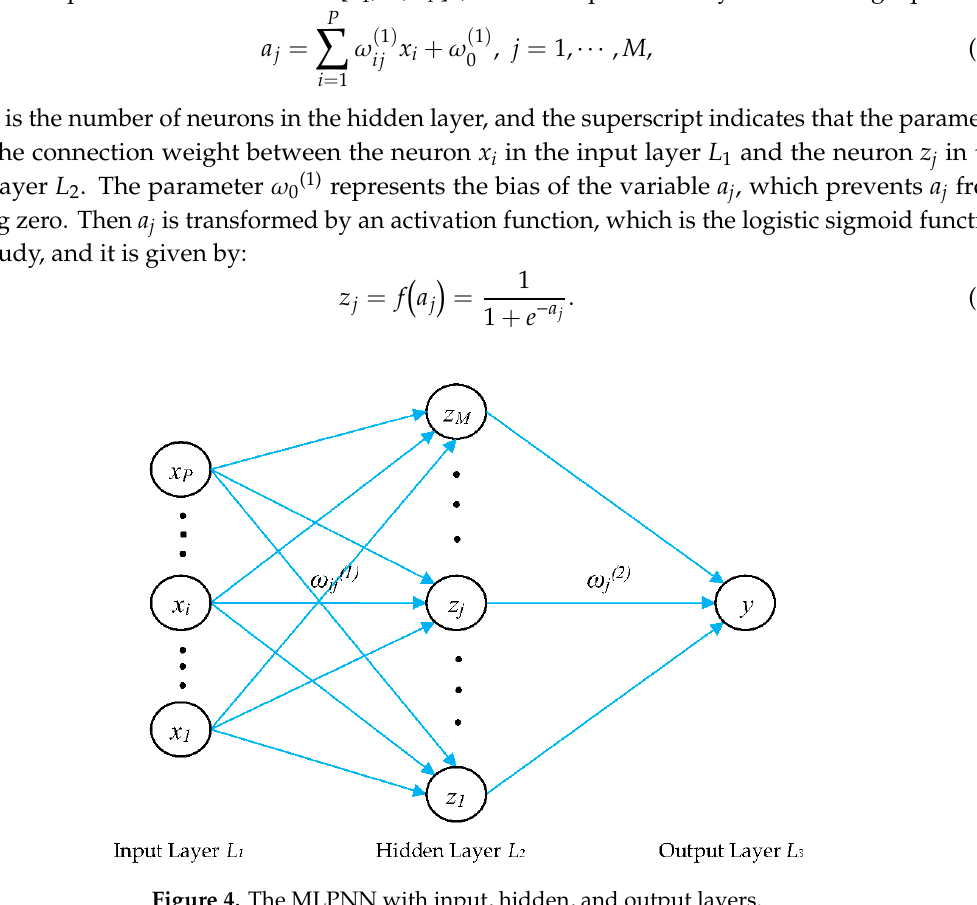
Figure 4. The MLPNN with input, hidden, and output layers.